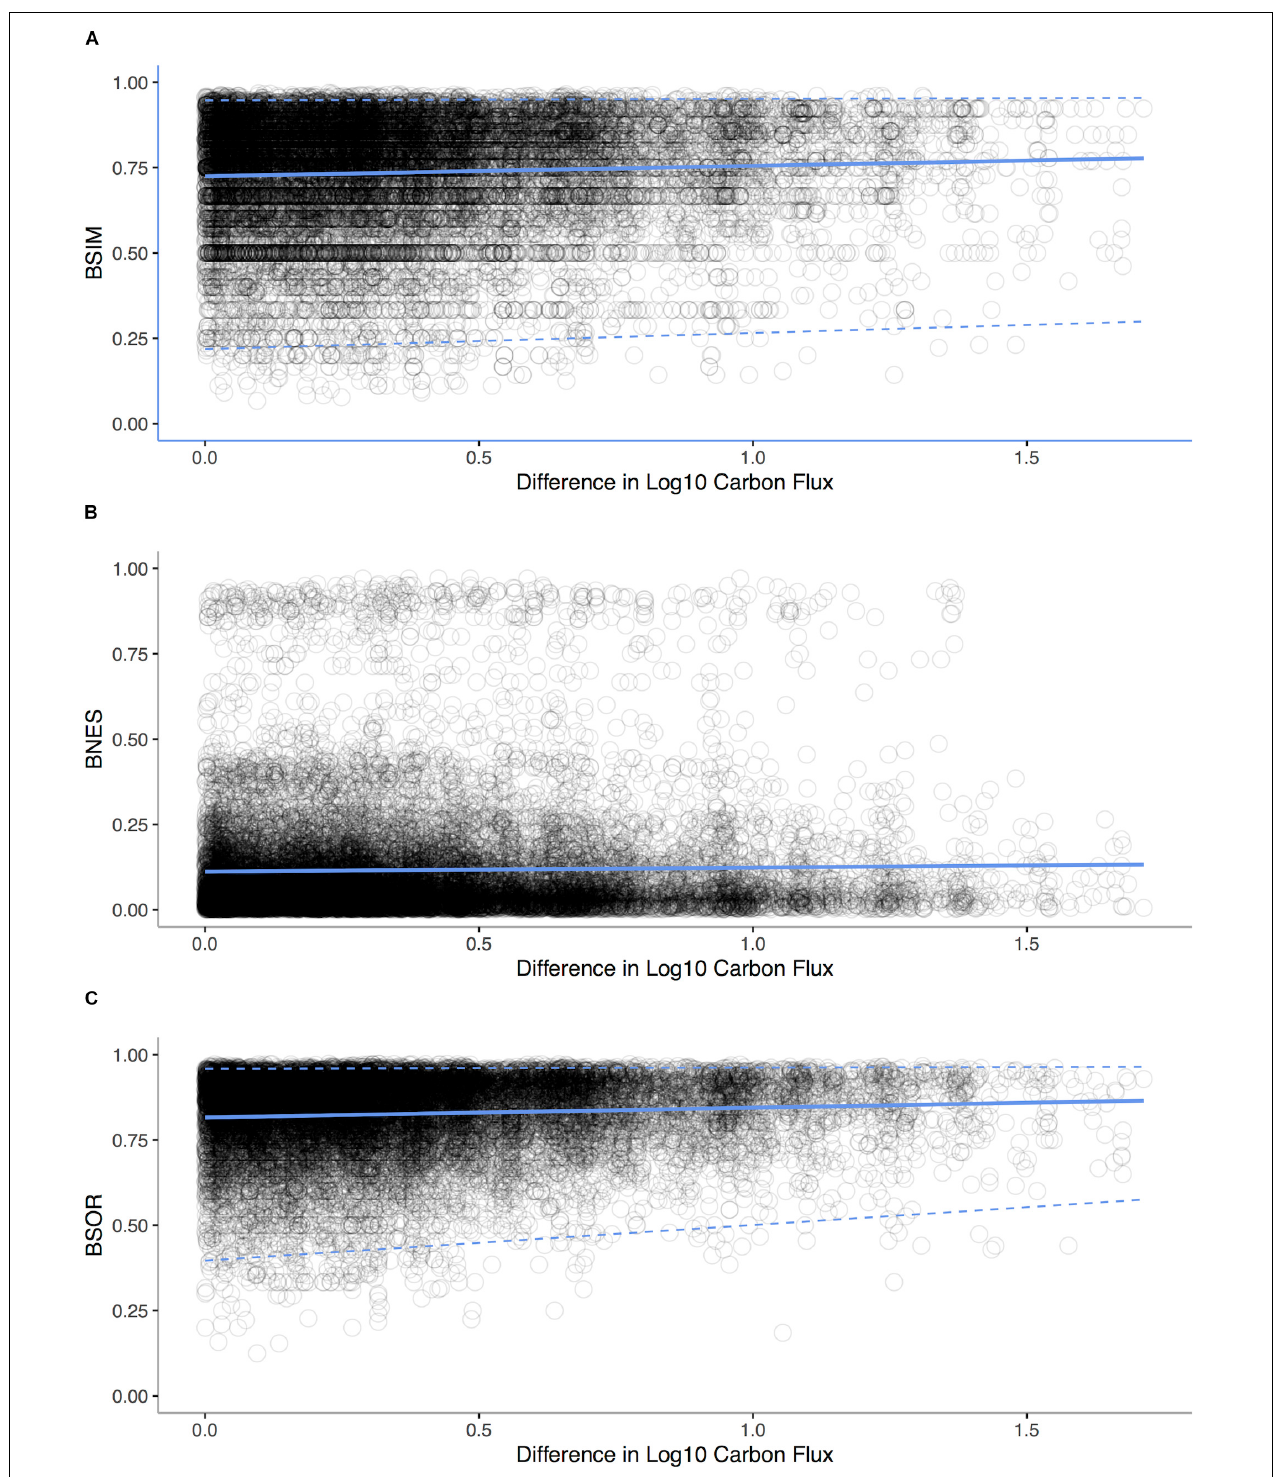
FIGURE 9 | Standard environmental distance-decay plots representing pairwise comparisons of bivalve community similarity verses differences in POC flux for each sampling station in the Atlantic Ocean. (A) Simpson’s index β SIM of dissimilarity due to turnover vs. difference in Log 10 Carbon Flux (gC m - 2 d - 1 , Mantel statistic r: 0.08, p < 0.0001). (B) Dissimilarity due to species loss leading to nestedness β NES verses Log 10 Carbon Flux (Mantel statistic r: -0.03, p = 0.904). (C) Sørensen’s dissimilarity index β SØR verses differences Log 10 Carbon Flux (Mantel statistic r: 0.11, p < 0.0001). Regression lines (solid lines) and quantile regressions lines (1 and 99%, dashed lines) are shown.